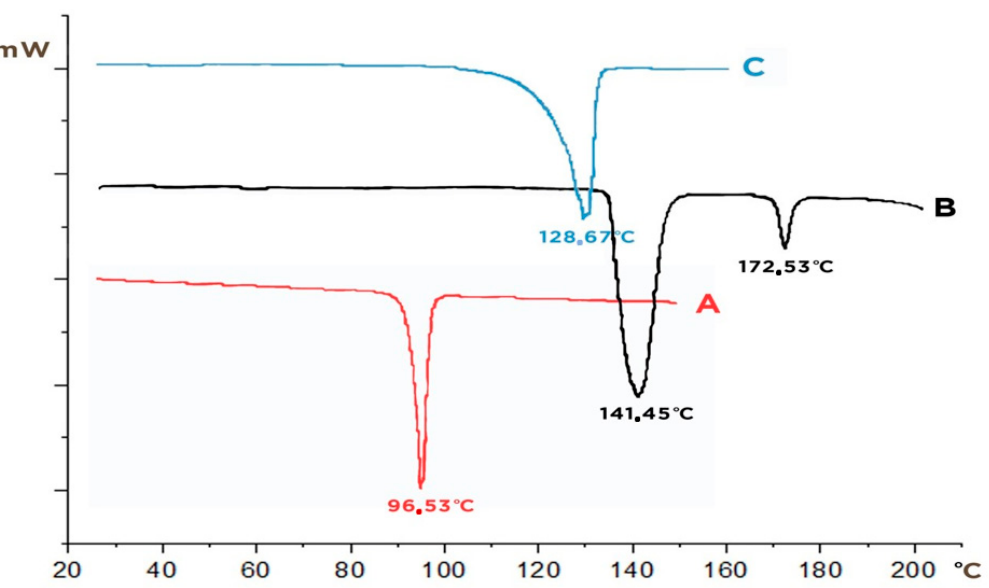
Figure 3. DSC thermogram of ( A ) ketoprofen, ( B ) tromethamine, and ( C ) multicomponent crystals of